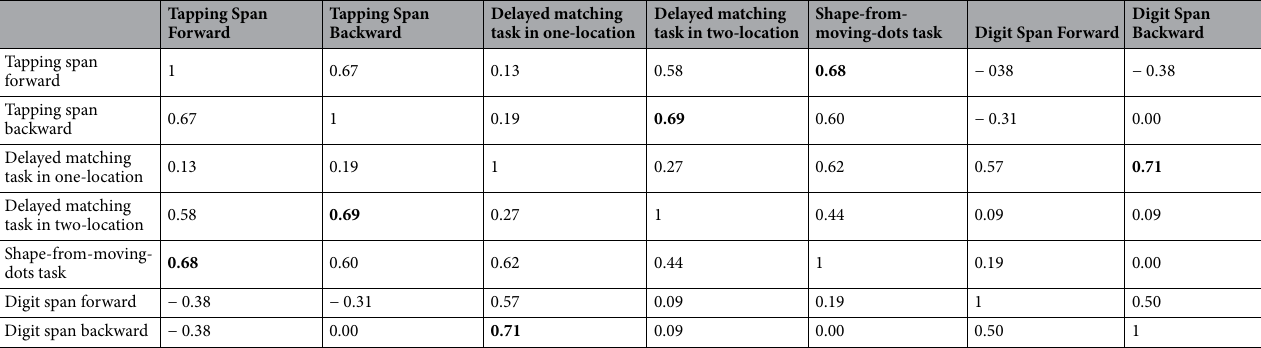
Table 5. Pearson’s correlation coefficient between tapping span and spatial working memory tests and between tapping span and digit span for the amnesic Alzheimer’s group. Bold values represent those with P-values of <